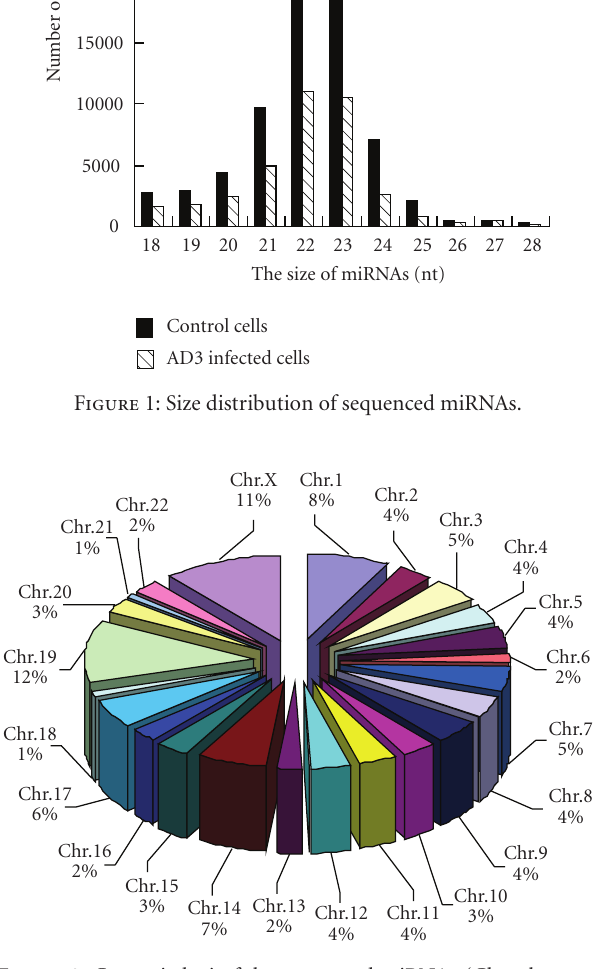
Figure 2: Genomic loci of the sequenced miRNAs (Chr: chromo- some). Table 1: Transcript loci of sequenced